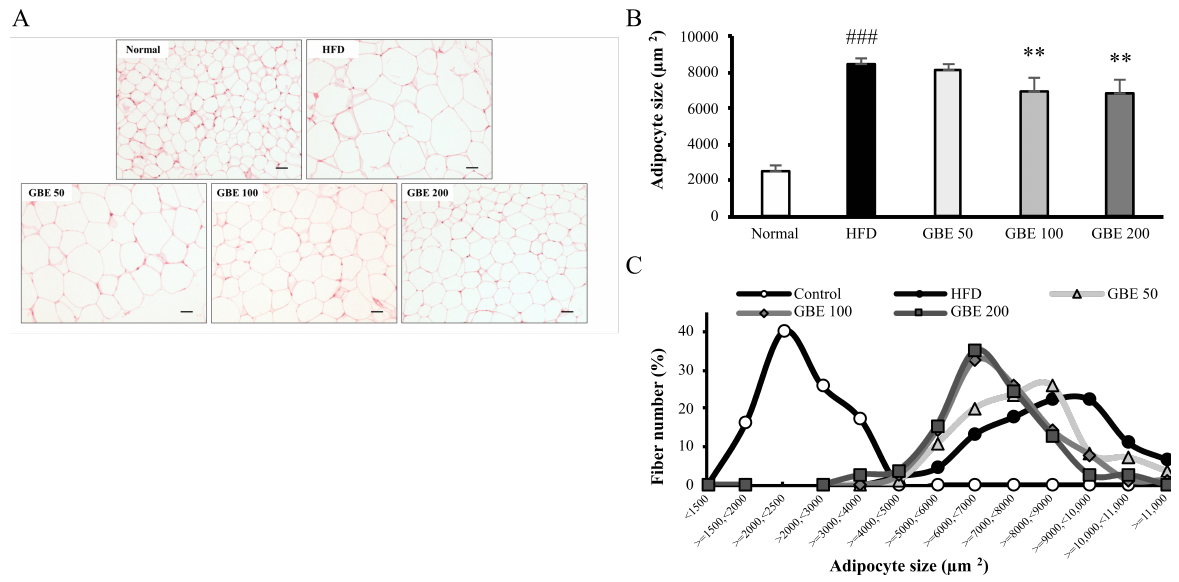
Figure 3. GBE administration significantly decreased adipocyte size. ( A ) H&E staining of epididymal fat. ( B ) The mean adipocyte size of epididymal fat. ( C ) The distribution graph of adipocyte size. Data are expressed as mean ± SD. ### p < 0.001 versus the normal group. ** p < 0.01 versus the HFD group.